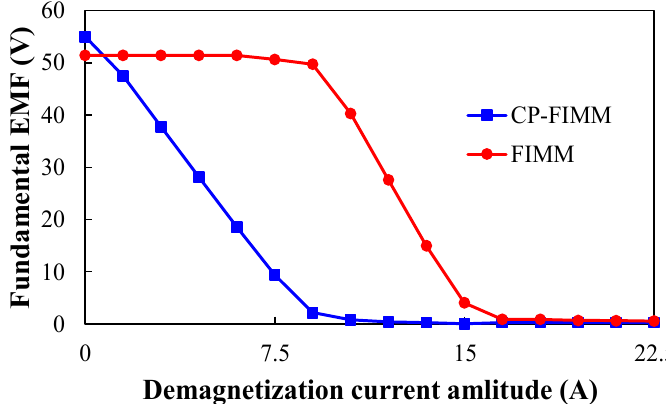
Energies 2022 , 15 , x FOR PEER REVIEW